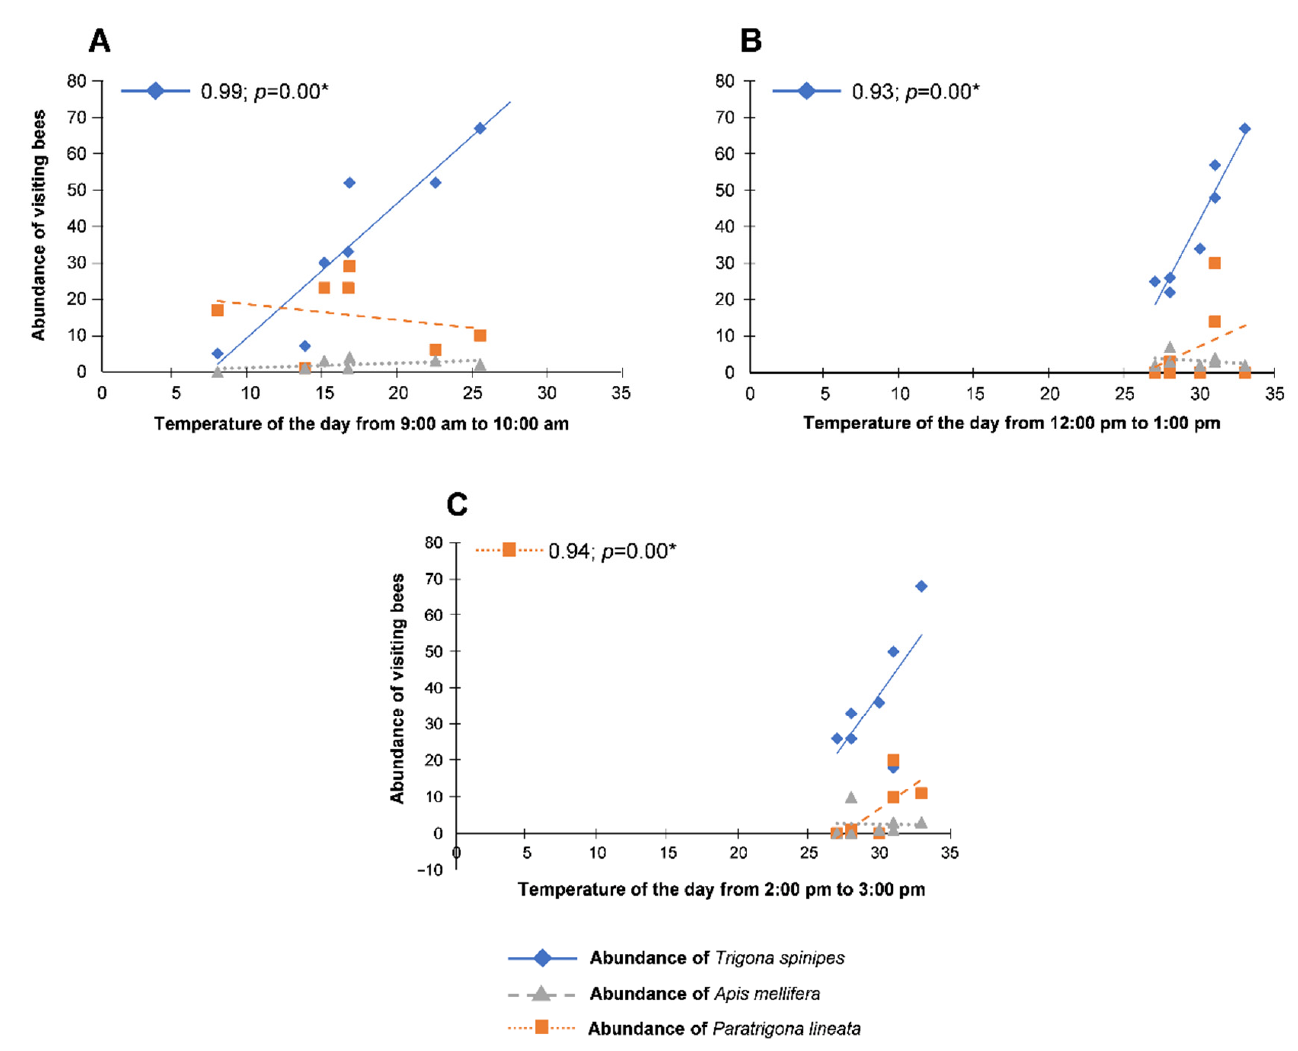
Figure 4. Dispersion corresponding to Spearman’s coefficient correlations between the abundance of visiting bee species and the temperature of the day in the three observation times, from 9:00 a.m. to 10:00 a.m. ( A ), 12:00 p.m. to 1:00 p.m. ( B ), and from 2:00 p.m. to 3:00 p.m. ( C ) during the seven weeks of flowering of Tropaeolum majus . * Statistical significance of spearman correlation, p -value ≤ 0.05.